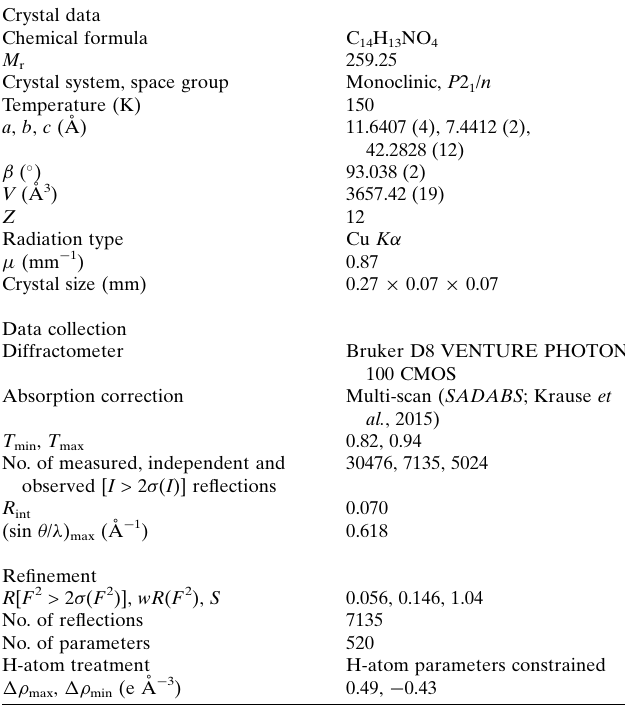
Table 4 Experimental details. Crystal data Chemical